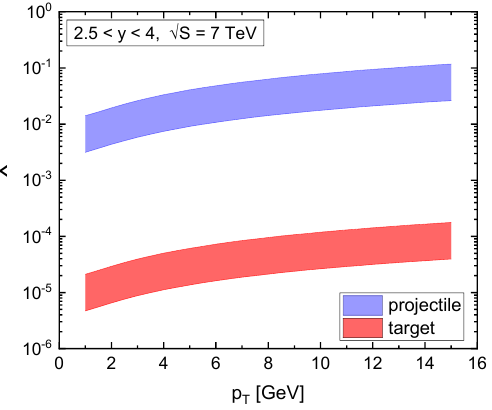
Figure 6 . Range of x values probed in the J= production at forward rapidities, both for projectile and target protons. Bands are de(cid:12)ned by the condition 2 : 5 < y <